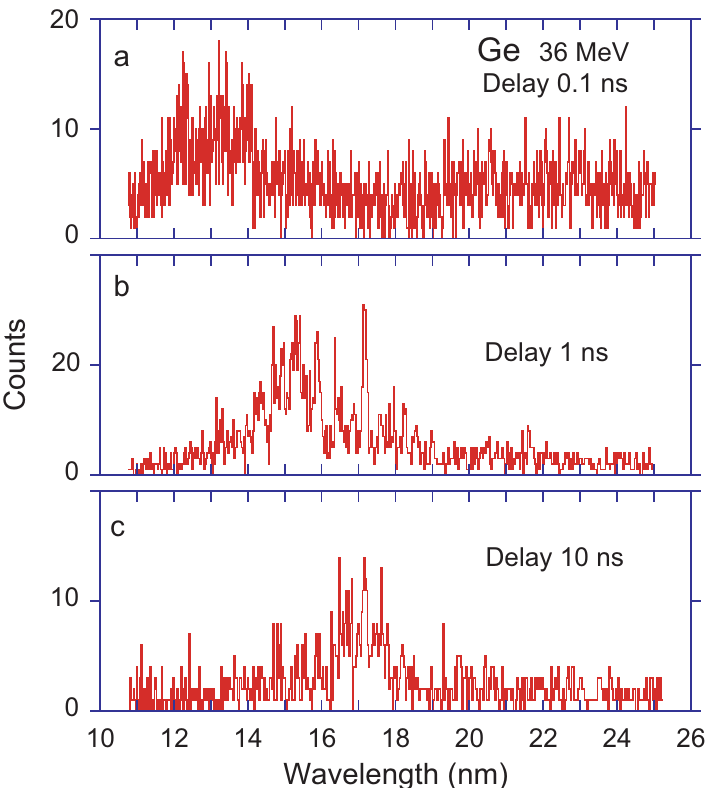
Figure 2. Beam–foil spectra of Ge at an ion beam energy of 36MeV. ( a ) Observation close to the foil, line width (FWHM) 0.045nm; ( b ) observation 10mm downstream of the foil (delay 1ns), line width (FWHM) 0.11nm; ( c ) observation 100mm downstream of the foil (delay 10ns), line width (FWHM)